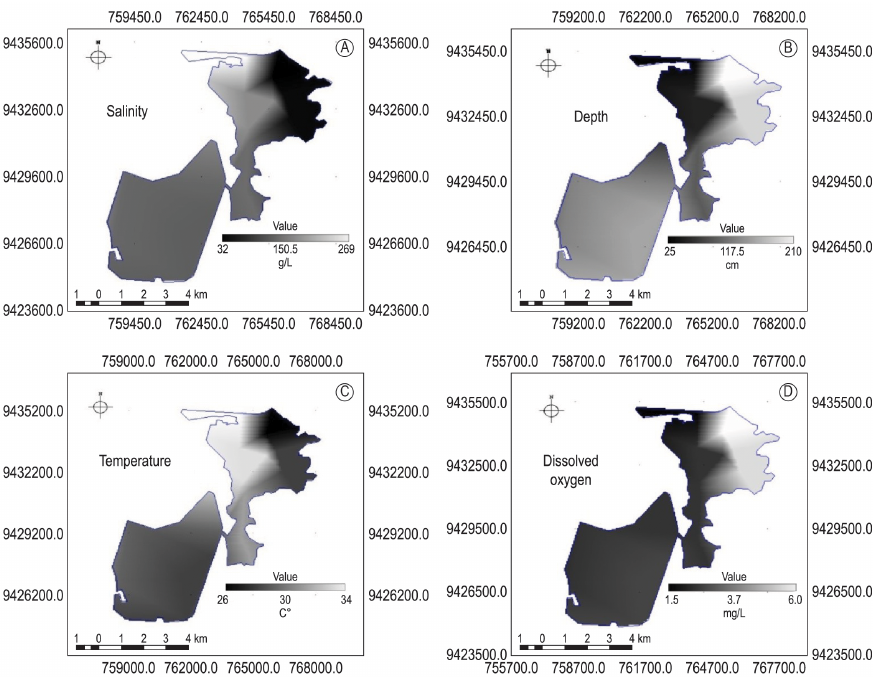
Figure 3. Spatial variation of salinity (A), depth (B), temperature (C) and dissolved oxygen (D) along the brine circuit on Unidos Solar